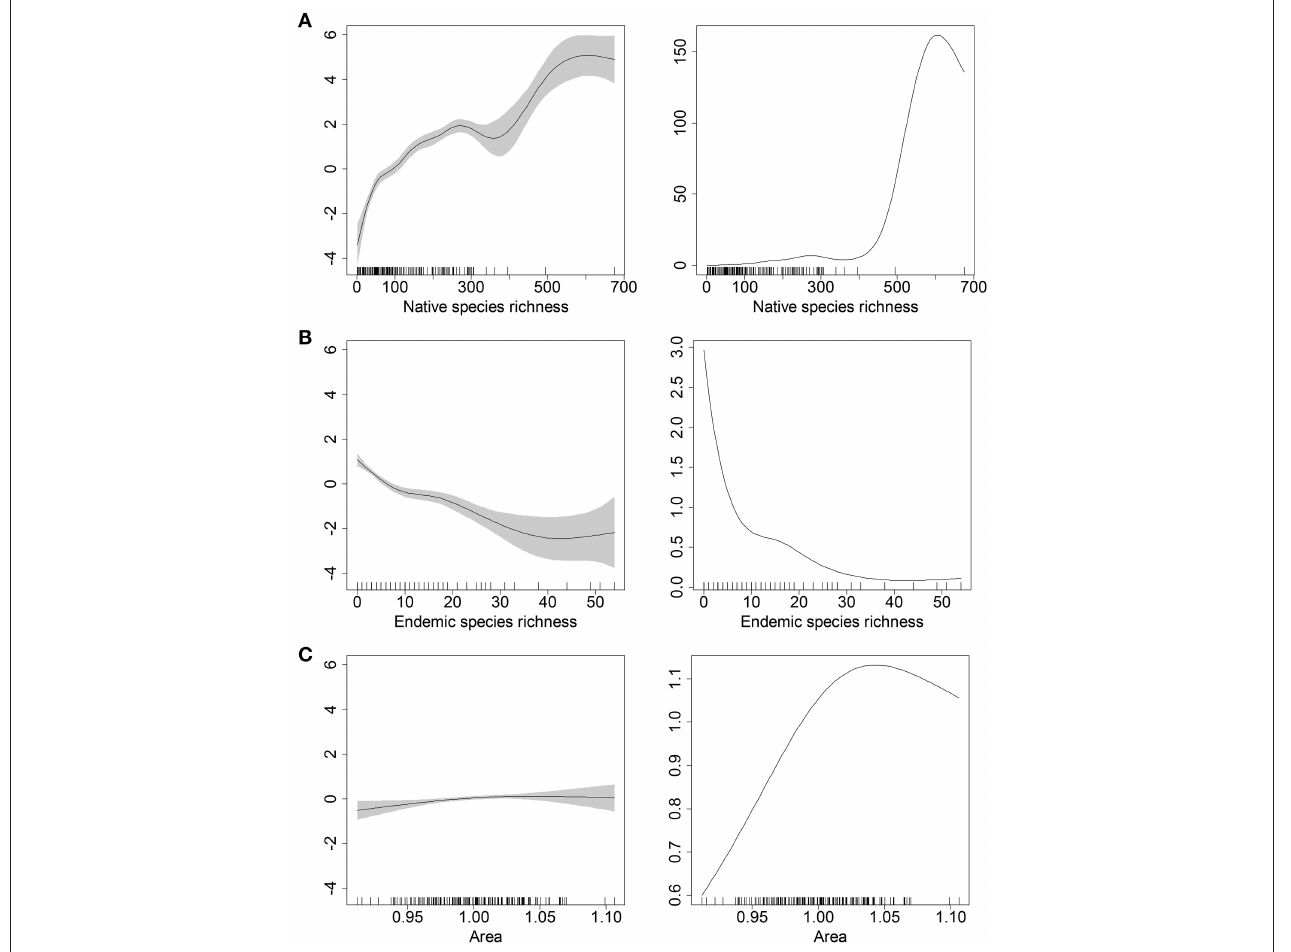
FIGURE 2 | Estimated smooth terms for the best model of alien species richness. The top panels (A) show the positive correlation between alien species richness and native species richness, (B) the middle panel shows the negative correlation with endemic species richness, and (C) bottom panel the relationship with area. For panels on the left, smooth terms (black lines) are given in the linear predictor scale and the corresponding 95% confidence intervals are indicated with gery intervals. For panels on the right, smooth terms are given in the response scale of the raw data (i.e., smooth terms were exp-transformed). The numbers after the commas in the y-axis titles are the estimated degrees of freedom of the smooth terms. Rug on the horizontal axis represents density of datapoints.